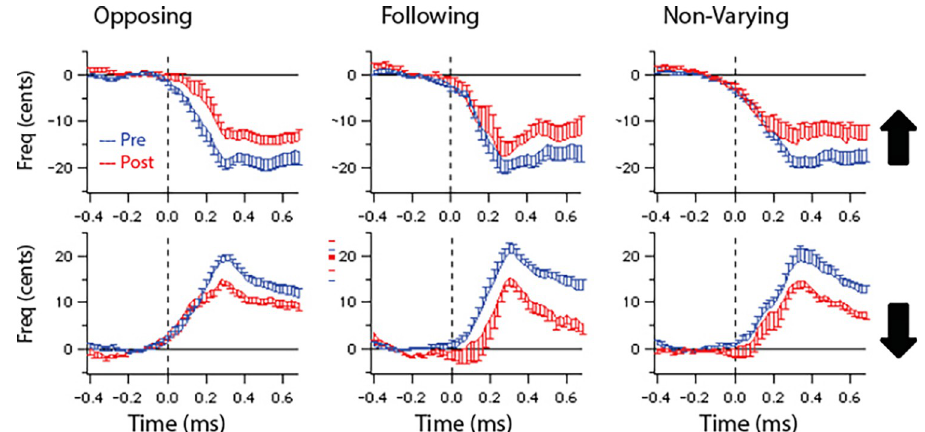
Fig 6. Grand-averaged vocal responses by group. Grand-averaged vocal responses to upward (top) and downward (bottom) pitch shifts for the a) opposing, b) following, and c) non-varying groups (blue line represents pre-training responses, red line represents post-training